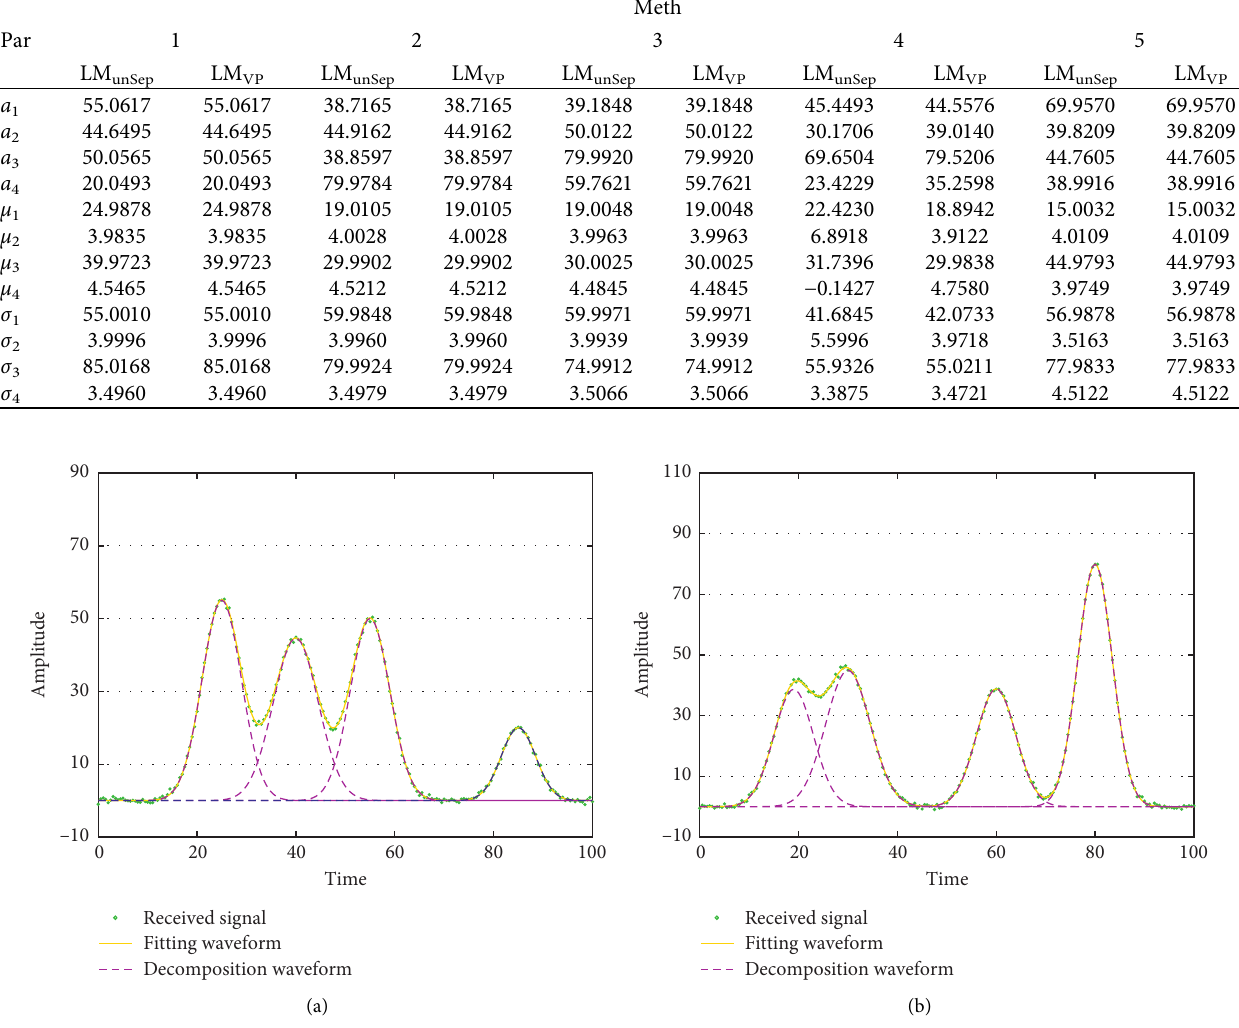
Table 2: Simulation results for the five groups of data calculated using the two methods without separation (LM (LM VP ) of